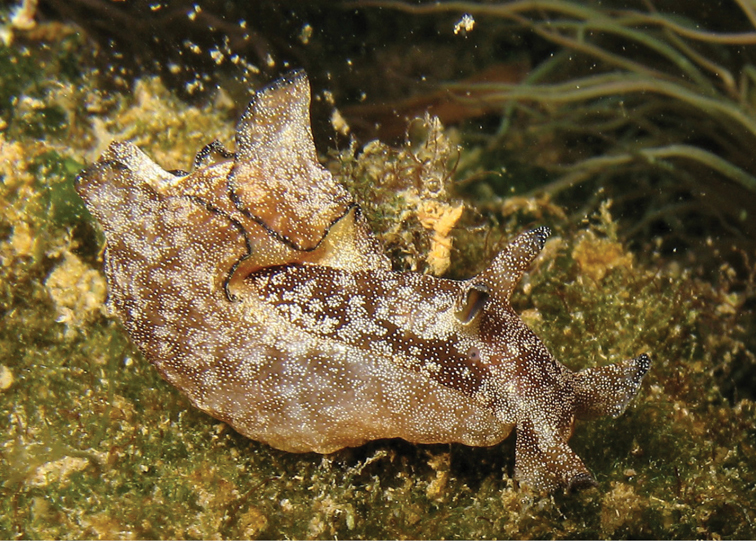
Aplysia parvula, 20 mm, La Réunion, photo: P Bidgrain (no spcm).